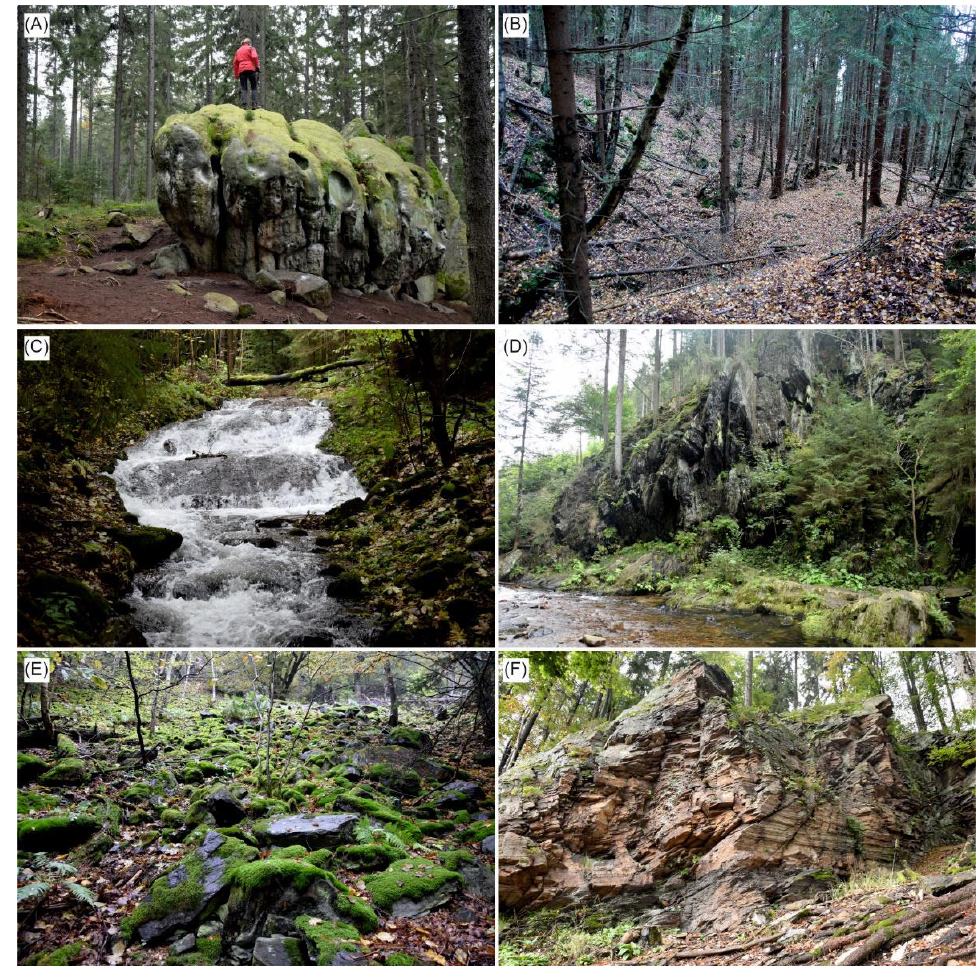
Figure 4. Selected potential geosites in the Orlické–Bystrzyckie Mountains Block, not included in any existing databases or inventories. ( A ) Huge residual sandstone blocks, Mt. Kamienna Góra (Poland); ( B ) head scarp and associated trenches form parts of landslide morphology at Mt. Toczek (Poland); ( C ) waterfalls in the Černovický potok valley (Czechia); ( D ) Plačtivá skála in the Zdobnice valley (Czechia); ( E ) slope blockfield in the Olešenka valley (Czechia); ( F ) rock cliffs in the Těchoninský potok valley (Czechia). Locations indicated on Figure 1.